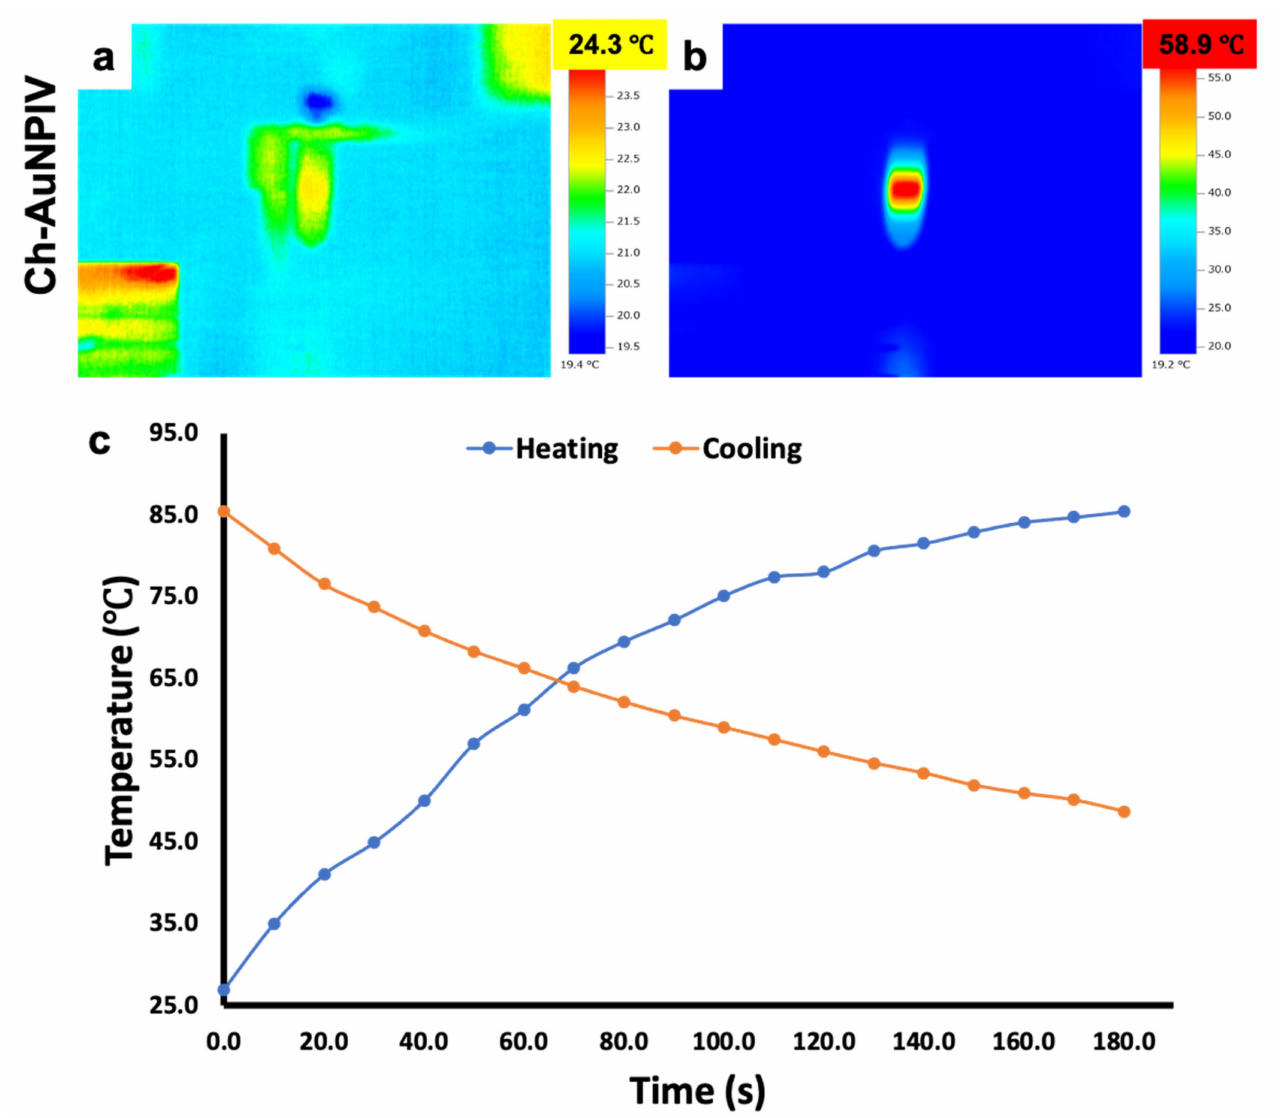
Figure 6. Photothermal responsiveness of the Ch-AuNPs under an external stimulus of NIR irradia- tion. ( a ) Depiction of the dispersion before the laser irradiation. The temperature rose rapidly once the NP solution was irradiated with the laser ( b ) which proves the known concept of AuNPs